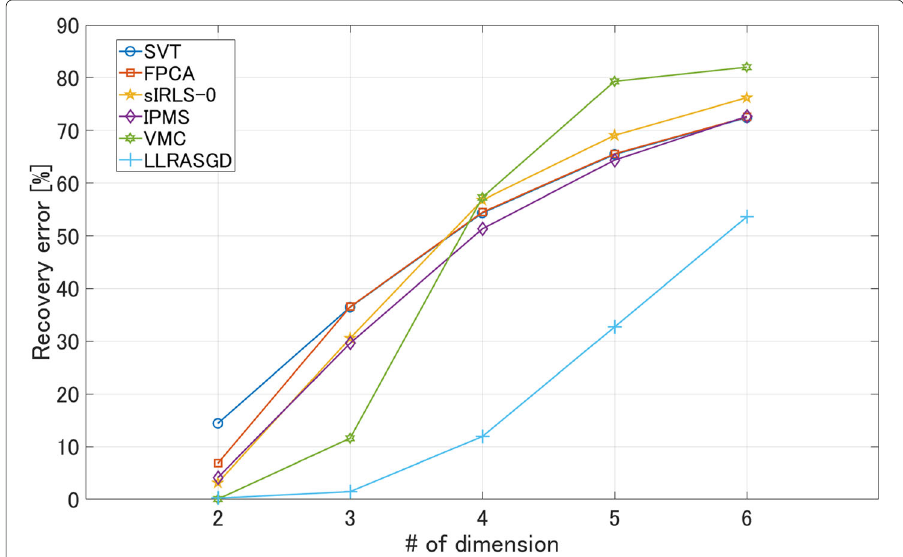
Fig. 3 Average RE for 10 trials with p = 7 for (20) and q =